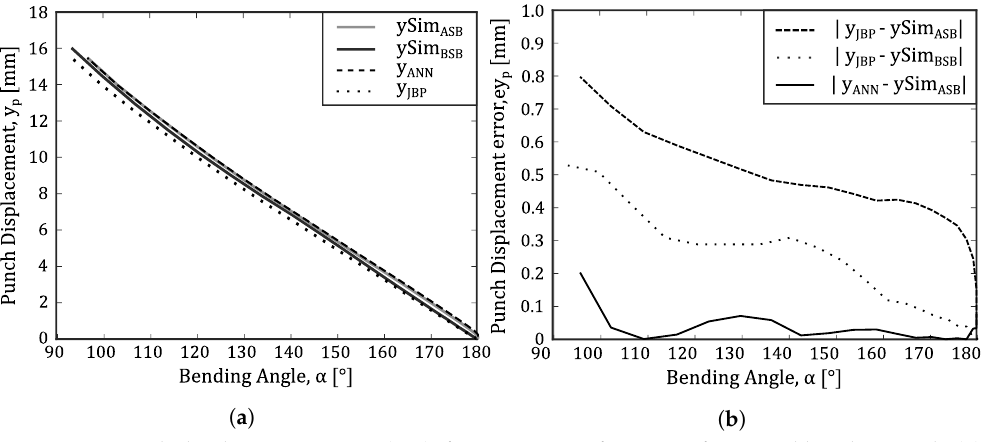
Figure 22. Punch displacement errors ( ey p ), for case B, as a function of required bending angle ( α ) considering ANN output values and JBP analytical results.